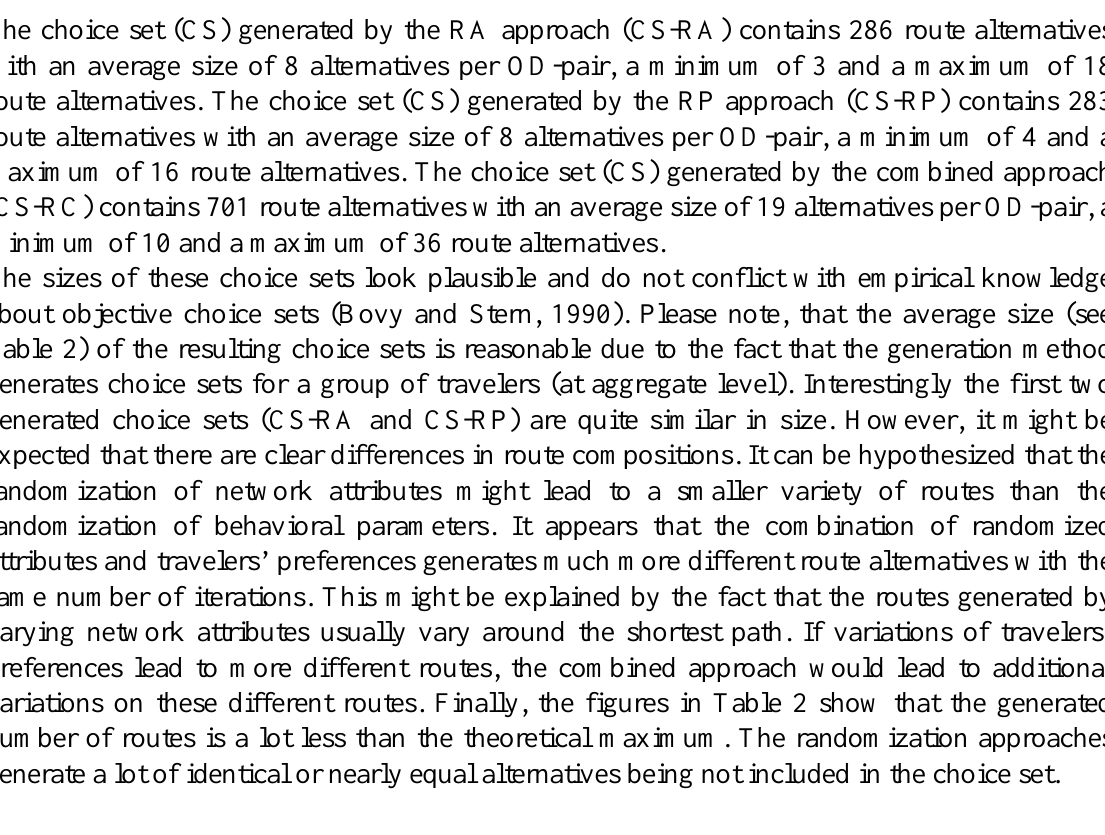
Table 2. Choice Set Generation Results for Sample of 37 OD-Pairs CS-RA CS-RP CS-RC Theoretical extreme Total number of distinct routes generated 286 283 701 1600 x 37 Average number of routes per choice set 8 8 19 1600 Coefficient Of Variation 52% 35% 32% Maximum Size 18 16 36 1600 Minimum